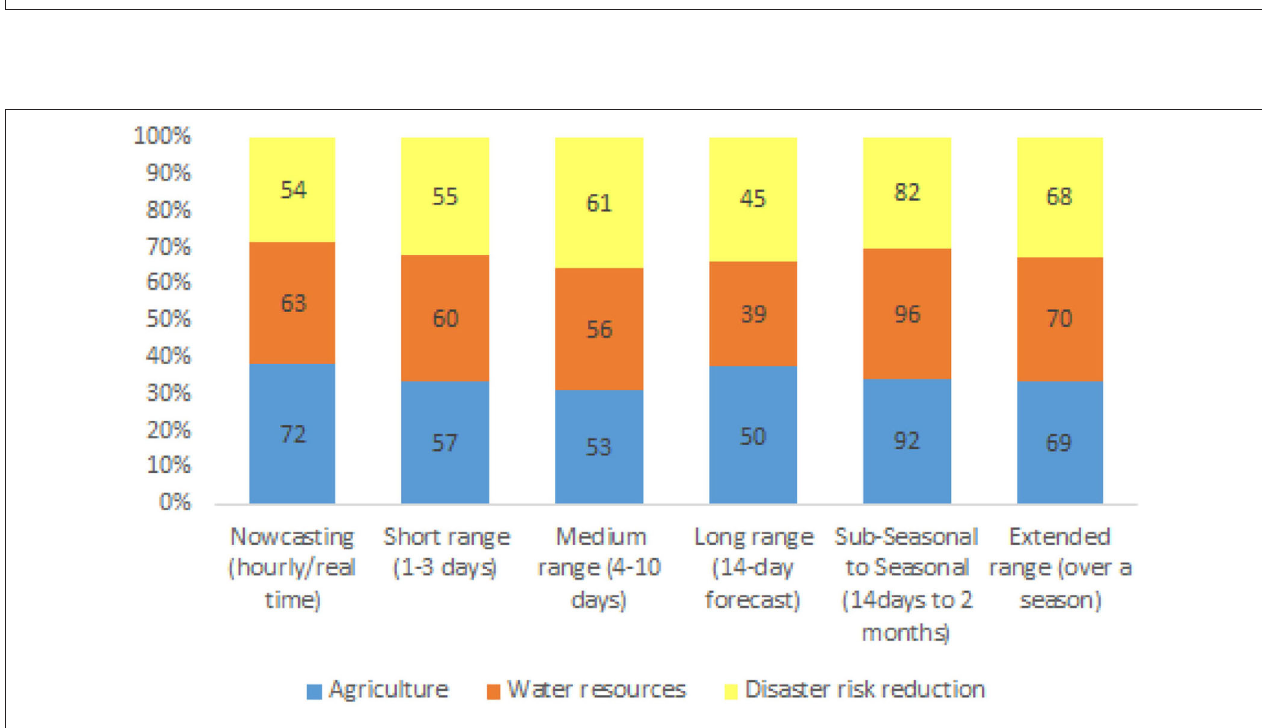
FIGURE 7 | Distribution of preferred WCI timescales by